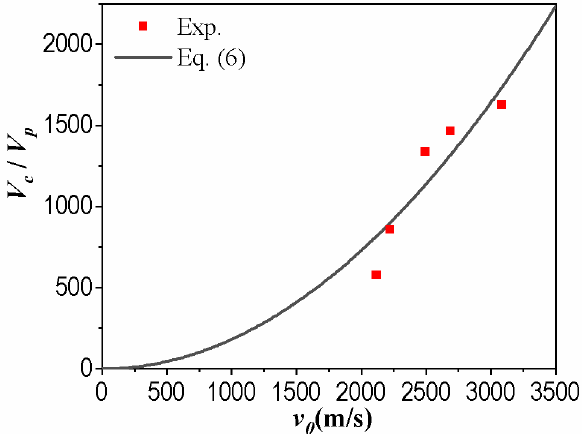
= 0.986, b . R 2 = 0.825).